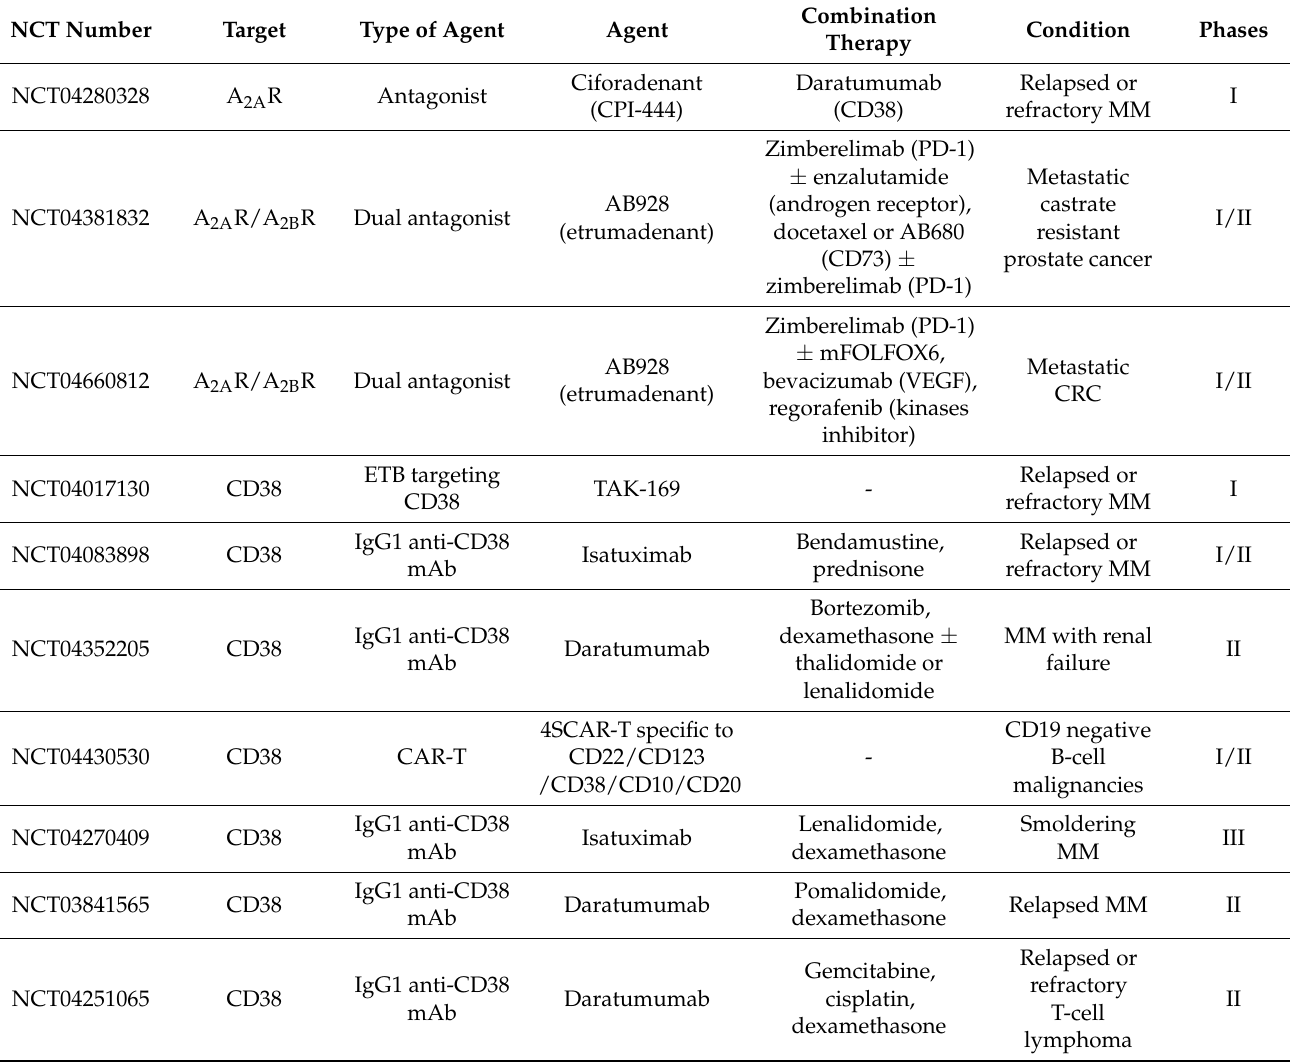
Table 1. Clinical trials targeting the adenosinergic pathway in malignancies initiated between 2020 and 2021 (source: ClinicalTrials.gov, accessed 30 September